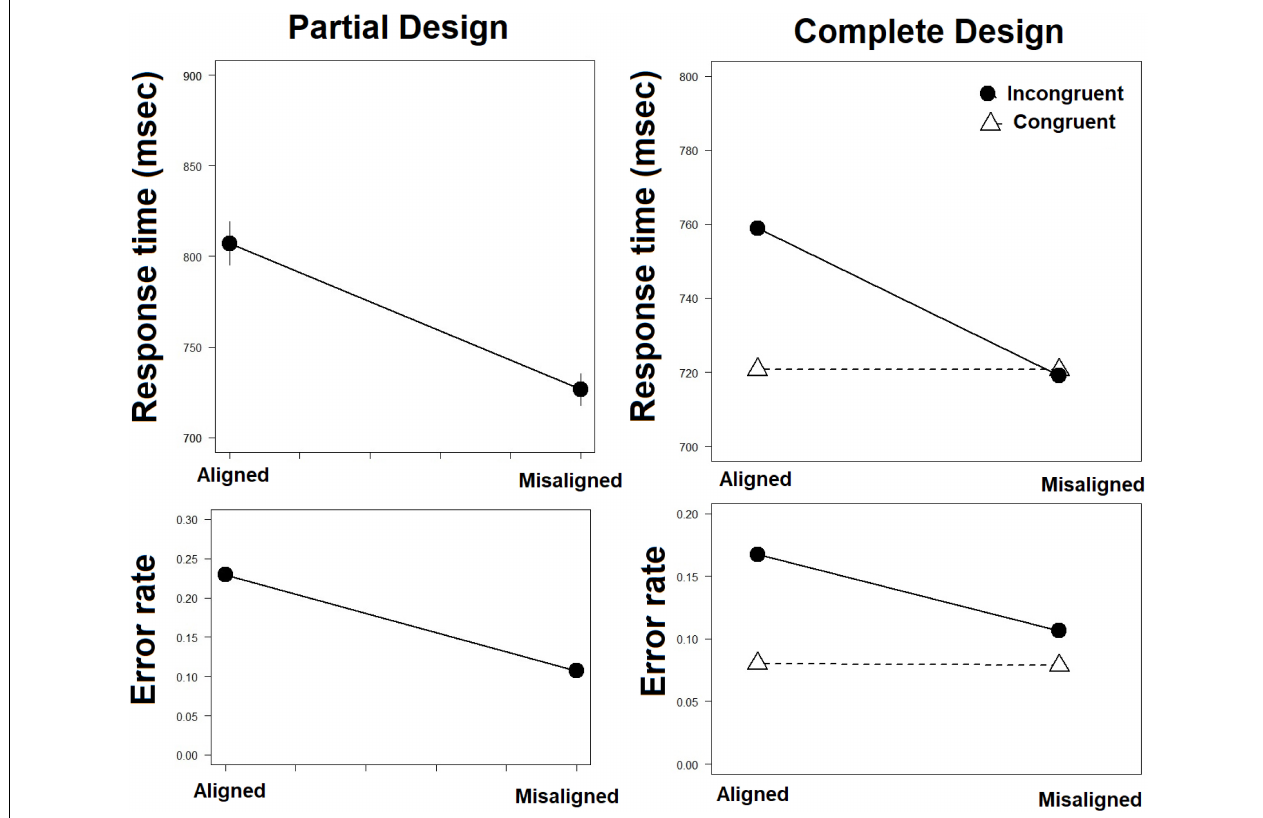
FIGURE 5 | Mean RTs and Error Rates in the complete (right) and partial (left)